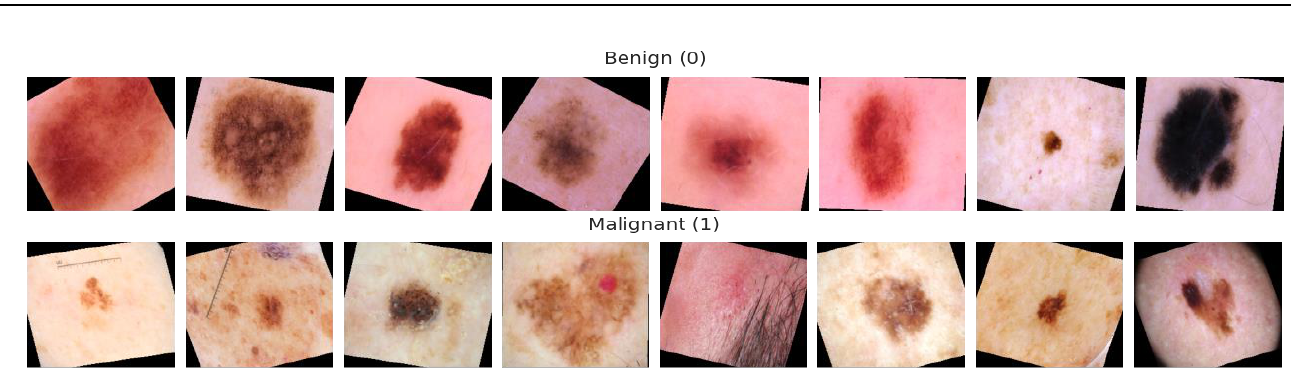
Figure 5. An example of data augmentation techniques applied on the selected datasets from the ISIC-2019, ISIC-2020, and HAM10000 sources in case of benign and malignant skin lesions.